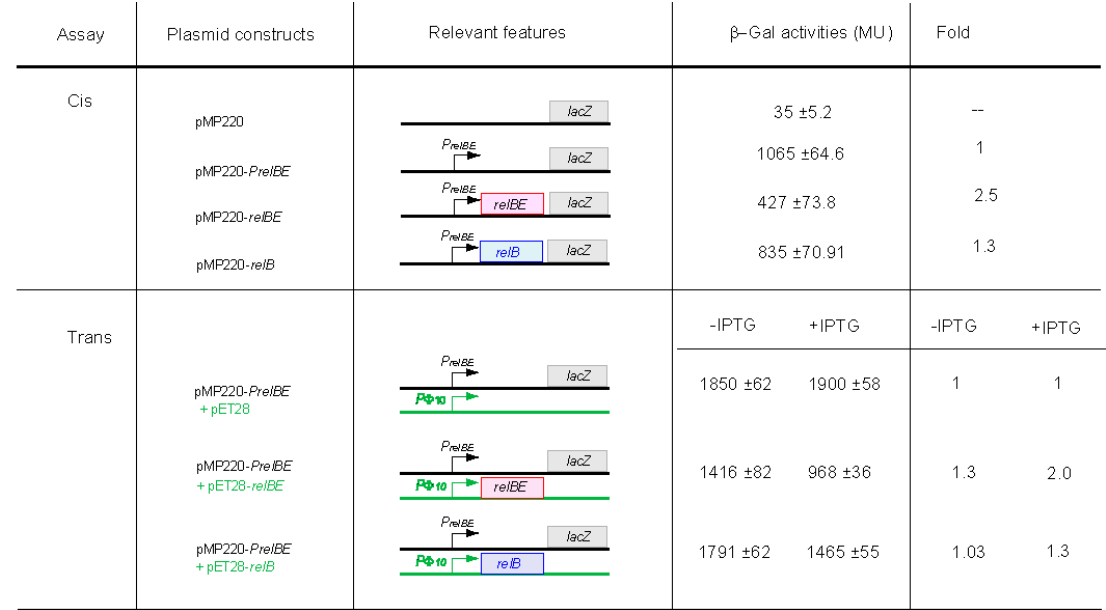
Figure 3. Control of expression by RelB and RelB:RelE proteins measured by β -galactosidase expression. Schematic diagrams of the recombinant plasmids carrying various relBE - lacZ transcriptional fusions, and their corresponding β -galactosidase activities. DNA fragments containing combinations of the relBE locus were cloned upstream of the promoterless lacZ gene (grey box) in pMP220, resulting in the various pMP220-derived recombinants as shown in the assays. When either the relBE or the relB products were supplied in trans, their synthesis was directed by the T7 Φ 10 promoter, inducible by IPTG, under which the pneumococcal genes were cloned into the compatible plasmid pET28. Fold indicates repression-fold, being 1 the values obtained from cultures carrying both the pMP220-P relBE plasmid vector and the pET28 ‘empty’ vector .